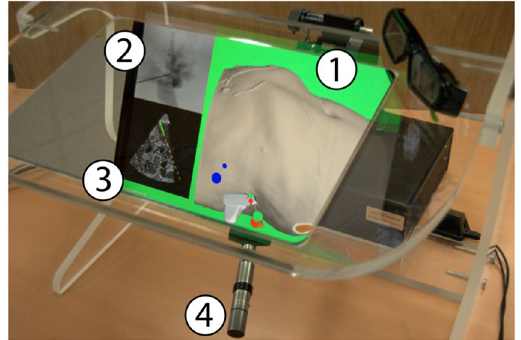
Figure 9. Haptic workbench and simulation: (1) Main rendering window, (2) X-ray rendering window, (3) ultrasound rendering window and (4) haptic device